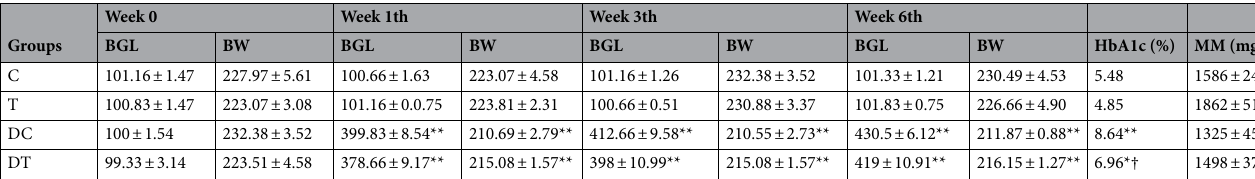
Table 1. Blood glucose levels, body weight and muscle mass in different experimental groups. C: control; DC: diabetic control; DT: diabetic training; T: control training; BGL: blood glucose levels (mg/dl); BW: body weight (g); MM: muscle mass. Repeated measures ANOVA and two-way ANOVA and Tukey’s post hoc test: * and ** showing p < 0.05 and p < 0.001 versus C, respectively. † p < 0.05 versus DC. Thirteen rats in each group were used for this